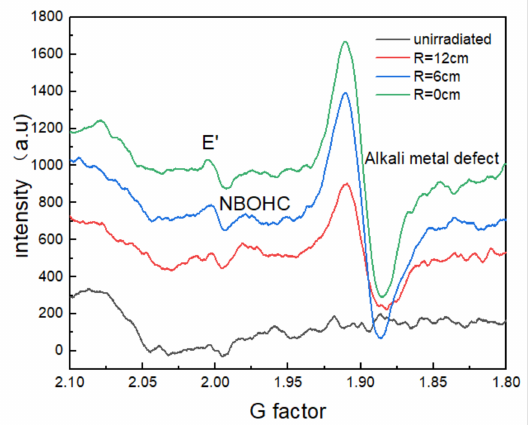
Figure 9. EPR spectra of nonirradiated and irradiated glass at different